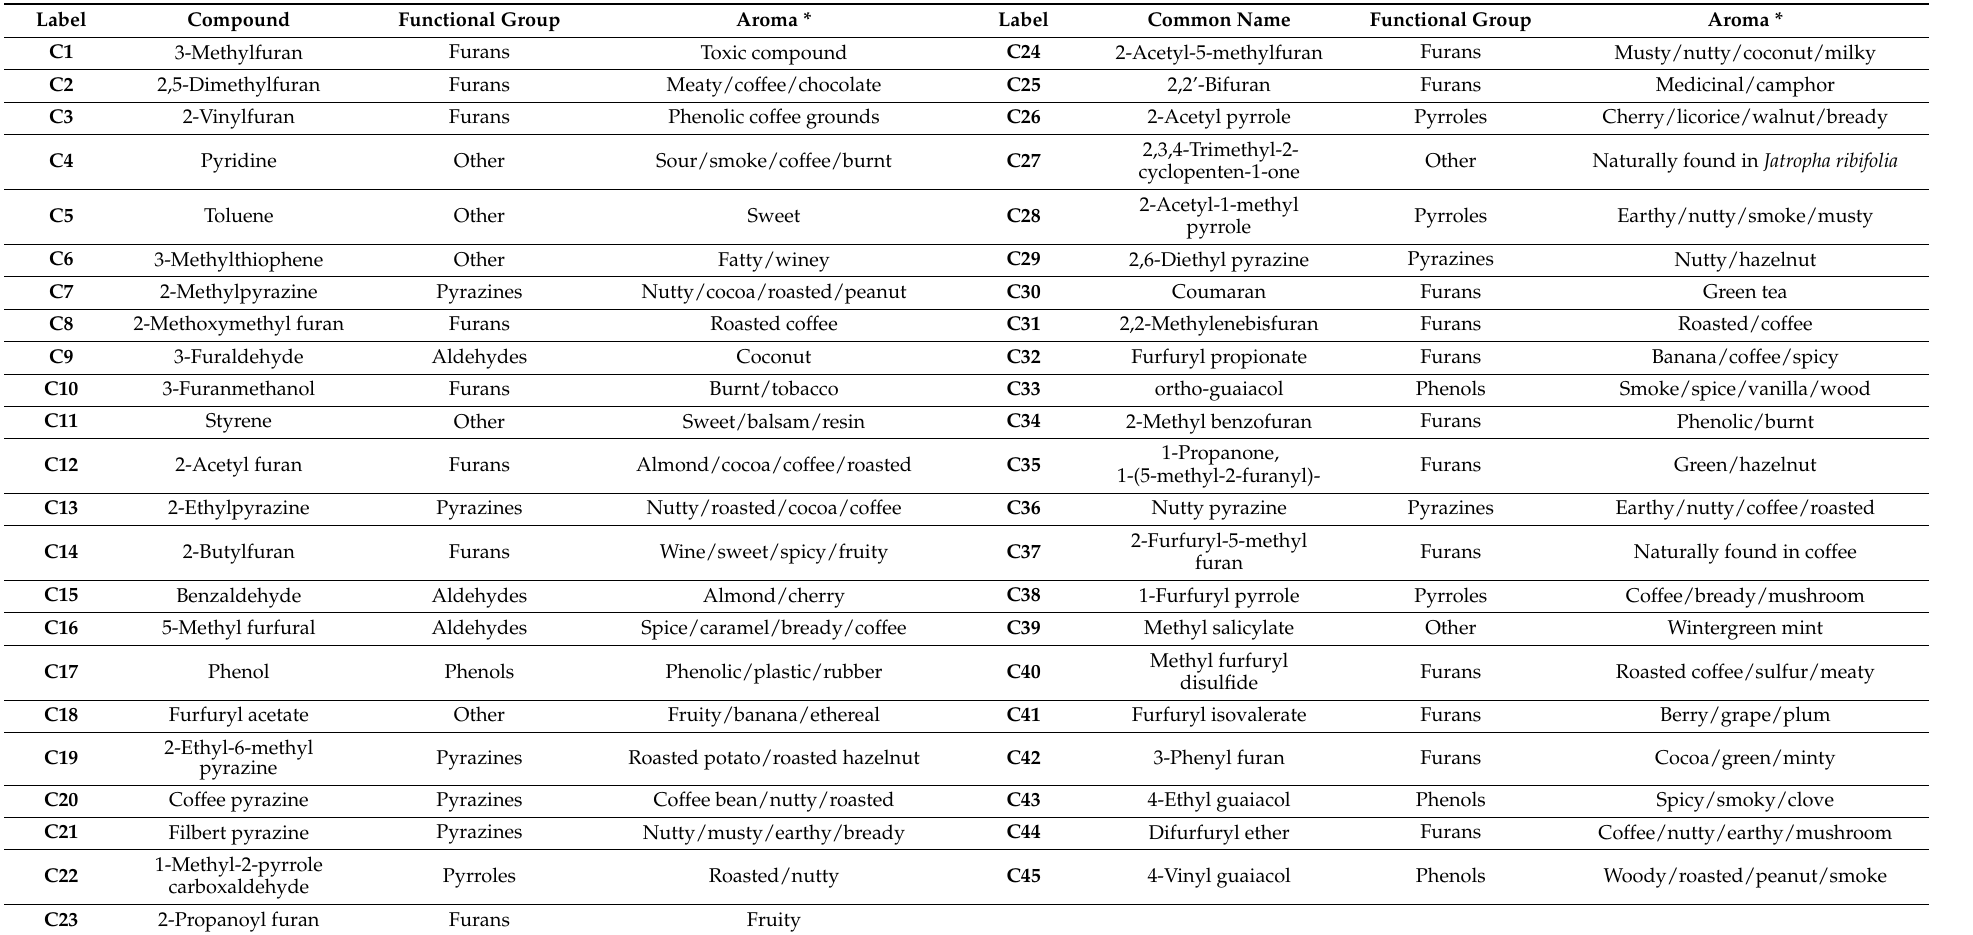
Table 3. Identified compounds from the gas chromatography mass-spectroscopy analysis, functional group, and their associated